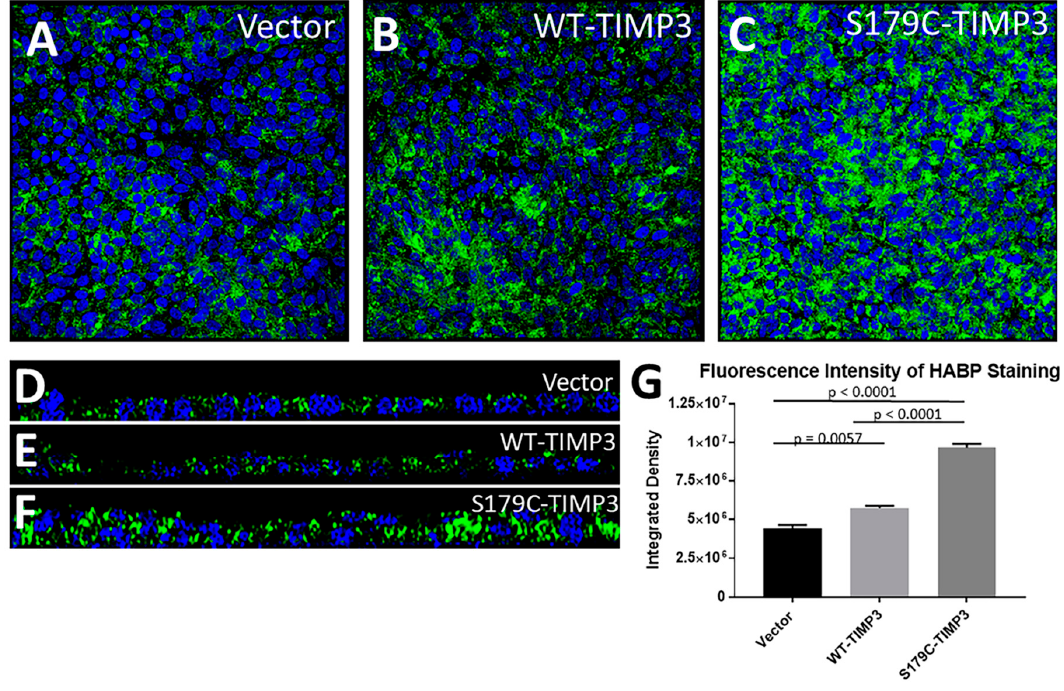
Figure 3. HA is increased in S179C-TIMP3 RPE cells in culture. ( A – C ) ARPE-19 cells expressing S179C- TIMP3 grown in culture for at least 2 weeks on trans-well inserts have increased HA ( C ) compared to WT-TIMP3 expressing cells ( B ) or vector only controls ( A ).( D – F ) Z-plane images of HA in RPE monolayers grown on trans-well inserts show increased intracellular HA in S179C-TIMP3 cells. Green: HA; blue: DAPI. ( G ) Fluorescence intensity was quantitated by integrated density measurement (n ≥ 4, for each cell line). Data are presented as mean ± SEM.